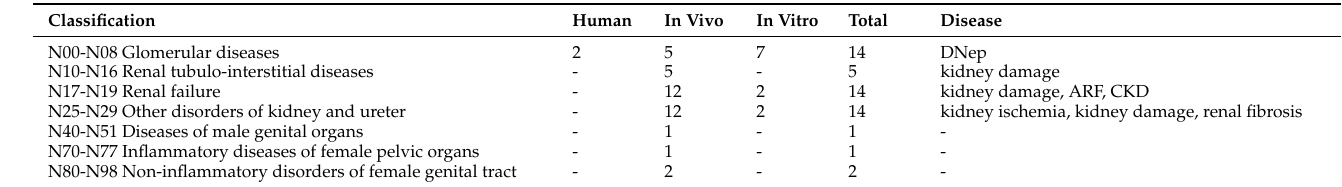
Table 8. The statistics of pharmacological results and its major diseases of SMC by experimental type in XIV Diseases of the genitourinary system of